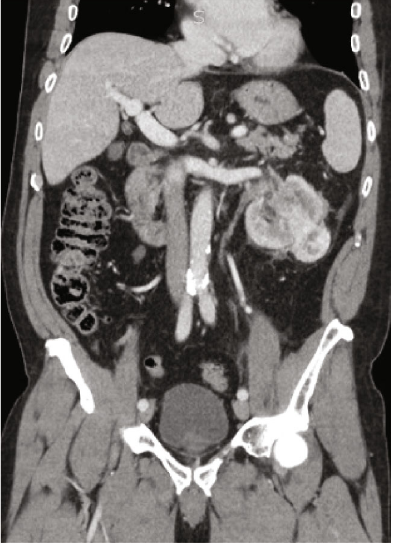
Figure 1: Computed tomography of renal mass demonstrating exophytic and in fi ltrative components of a 9cm left interpole renal